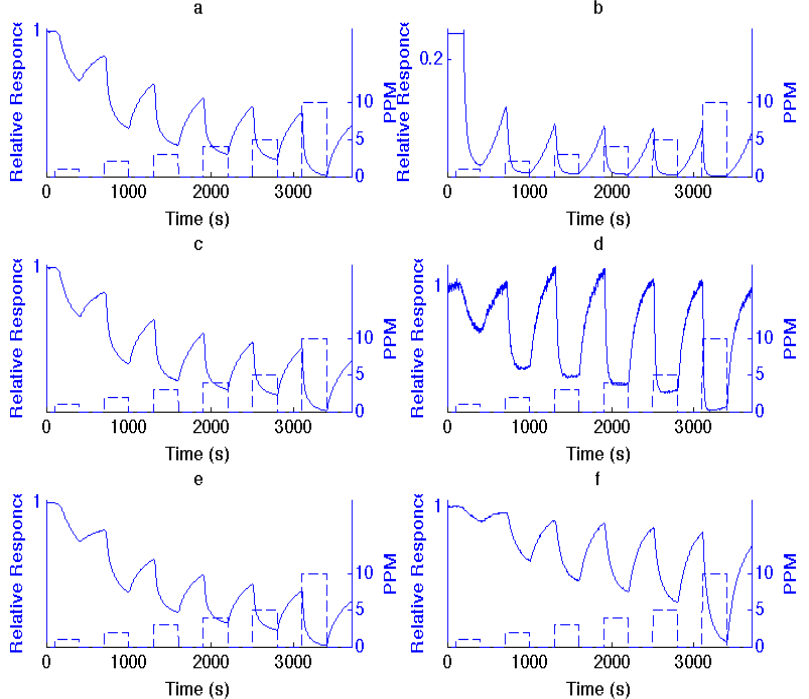
Figure 1. Comparison of responses to 1, 2, 3, 4, 5 and 10 ppm NH sensors, consisting of an untreated n -type porous silicon (PS) interface with those treated with ( b ) TiO , ( d ) SnO and ( f ) NiO fractional nanostructured island depositions. The PS 2 x interface in (a) is that treated with TiO in (b) and similarly for SnO 2